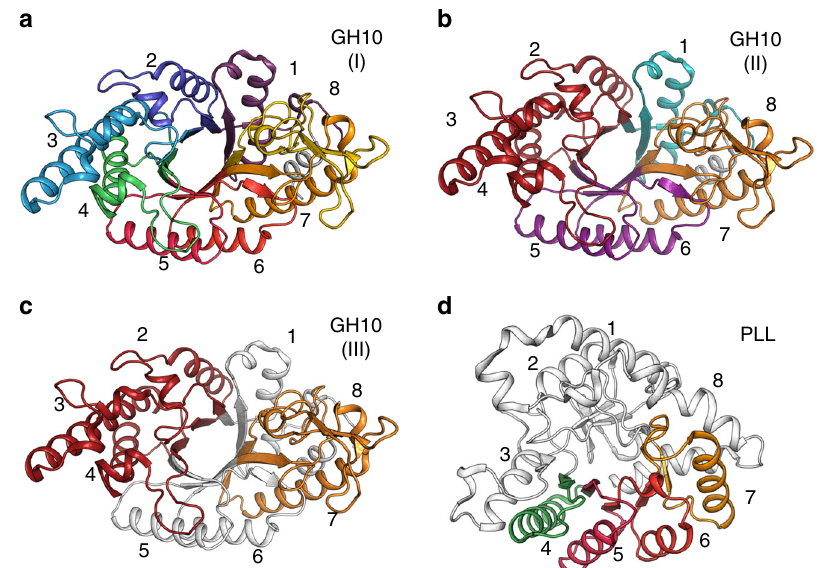
Fig. 2 Different segmentation schemes used in combinatorial backbone assembly. a GH10(I): Each of eight β - α units were sampled independently, for maximal backbone diversity. b GH10(II): Segmenting β - α units 1, 2-4, 5 – 6, and 7 – 8 to preserve stabilizing interactions within each segment. c GH10(III): a discontinuous segmentation, in which the structurally conserved β - α units 1 and 5 – 6 formed one segment and two other segments were formed by units 2 – 4 and 7 – 8. d The homodimer interface in PLLs ( β - α units 1 – 3 and 8, gray) was used as one backbone segment and units 4 – 7 were sampled